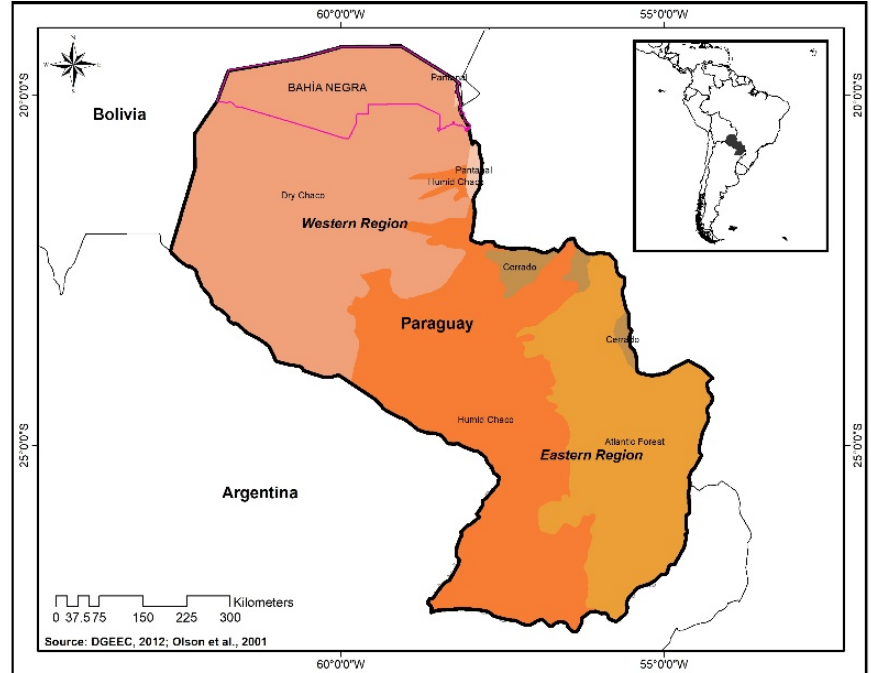
Figure 1. Location of Paraguay in South America, its two regions: Eastern and Western, and its ecoregions.